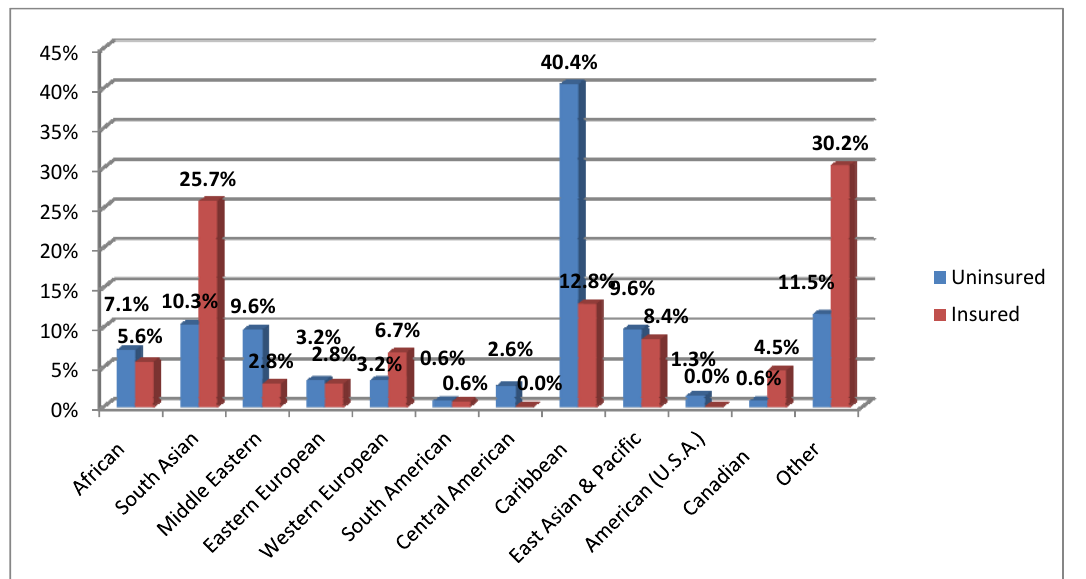
Figure 1. Ethnic background by insurance status ( n =